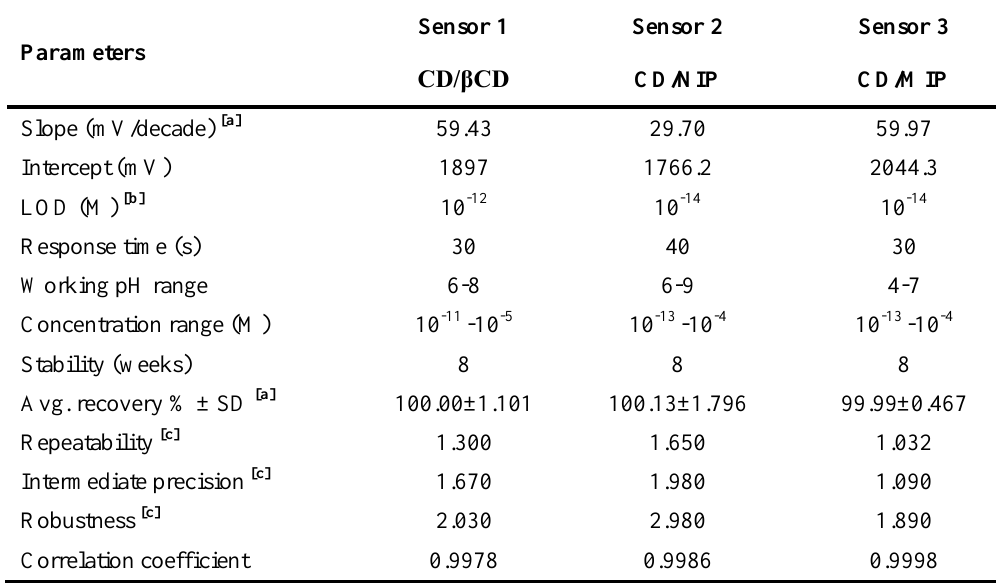
[a] Average of seven determinations for sensor 1, ten for sensors 2 and 3. [b] Limit of detection was measured by interception of extrapolated arms of calibration curves. [c] Precision parameters expressed in